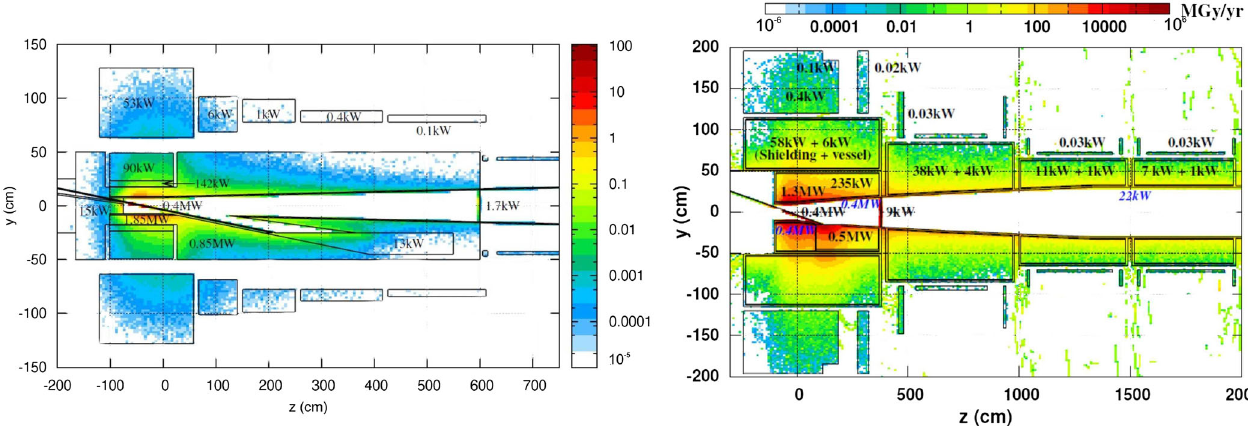
FIG. 4. Simulation of power dissipation due to radiation in the target station region for the Study 2a target design [56] (left panel) and the EURO ν baseline target station (right panel).